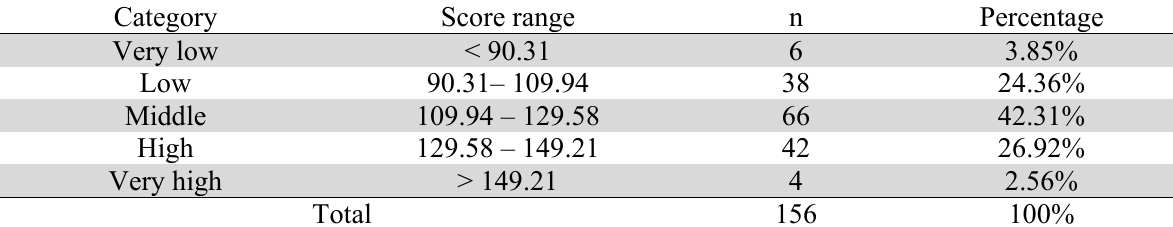
Categorization of prosocial behavior score Category